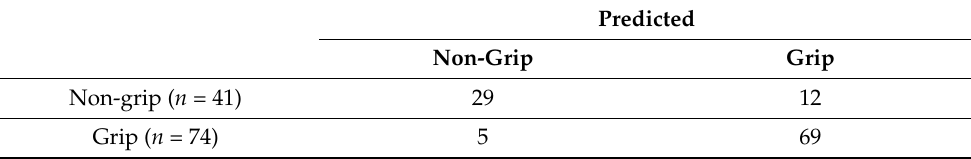
Table 2. Confusion matrix for the decision tree model in the case of Environment 2.